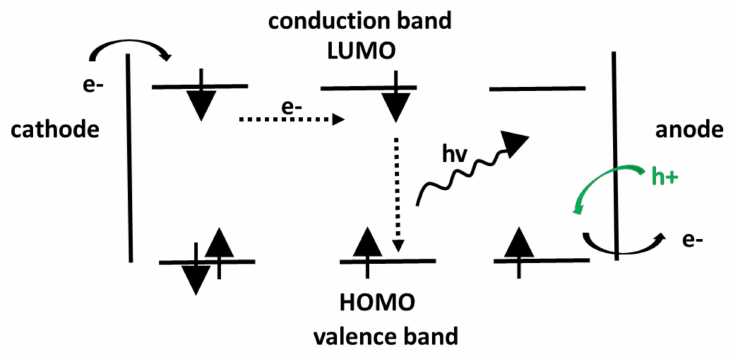
Figure 15. Schematic presentation of electroluminescence. Figure adapted from